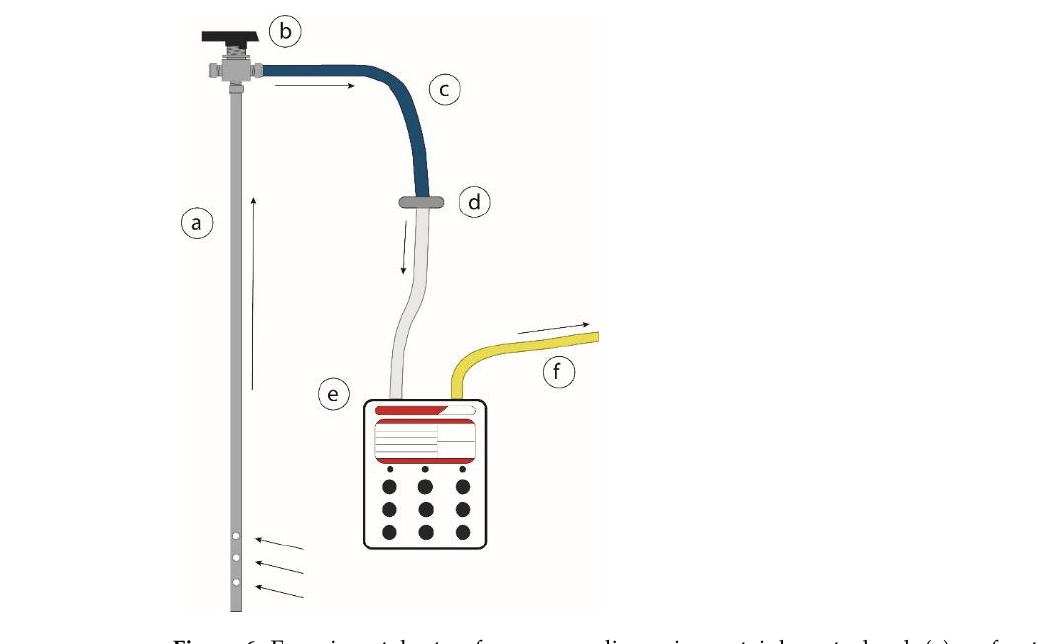
Figure 6. Experimental setup for gas sampling using a stainless-steel rod: ( a ) perforated stainless steel rod; ( b ) three-way valve; ( c ) flexible plastic tubing (inlet); ( d ) waterproof Teflon water vapor filter; ( e ) gas analyzer tool; ( f ) flexible plastic tubing (outlet). Gaseous emanations from soils are often characterized by zones of concentric alteration where they emerge, with alteration including clays, oxides, and sulfides. In such cases, our protocol (Figure 7) was as follows.